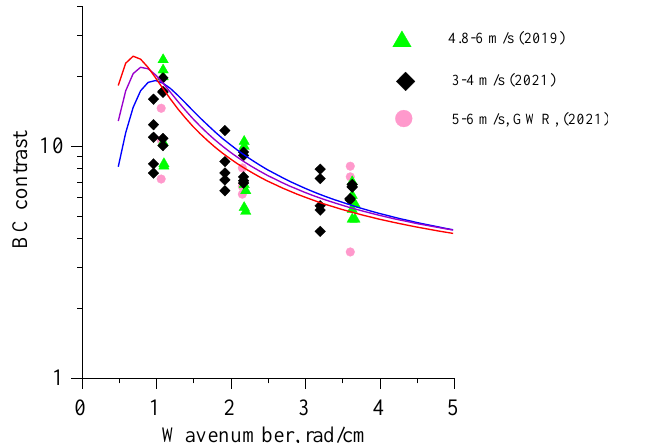
Figure 12. Comparison between experimental BC contrasts for crosswind observations in experiments of 2021 and 2019 (see, [45]) and theory (16) at film elasticity of 20 mN/m, 25 mN/m, and 30 mN/m (blue, violet, and red curves, respectively).